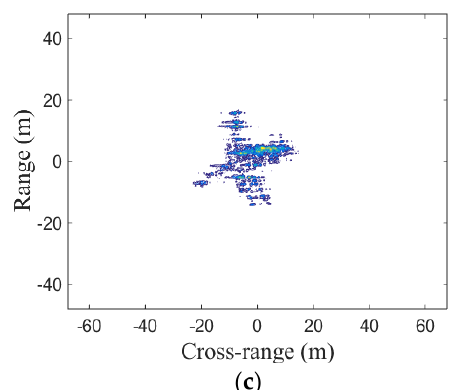
Figure 8. Coherent fusion imaging results under large LTFE: ( a ) imaging result without large LTFE; ( b ) imaging result with large LTFE; ( c ) imaging result after calibrating large LTFE.